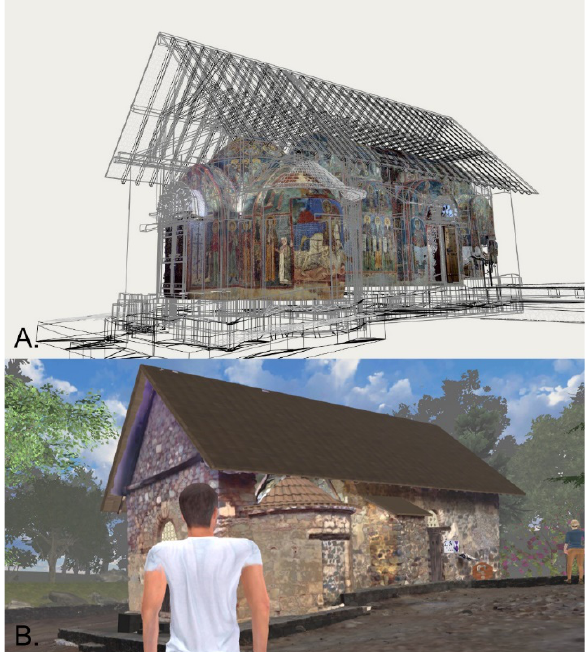
Figure 11. Asinou Church H-BIM and Unity model, A. the merged of the interior - frescoes mesh model and point cloud of the12th-century Byzantine paintings with the H-BIM inside Rhinoceros 3D through the adaptive parametric algorithm, B. The game environment with the 3d textured mesh model merged with the H-BIM model.